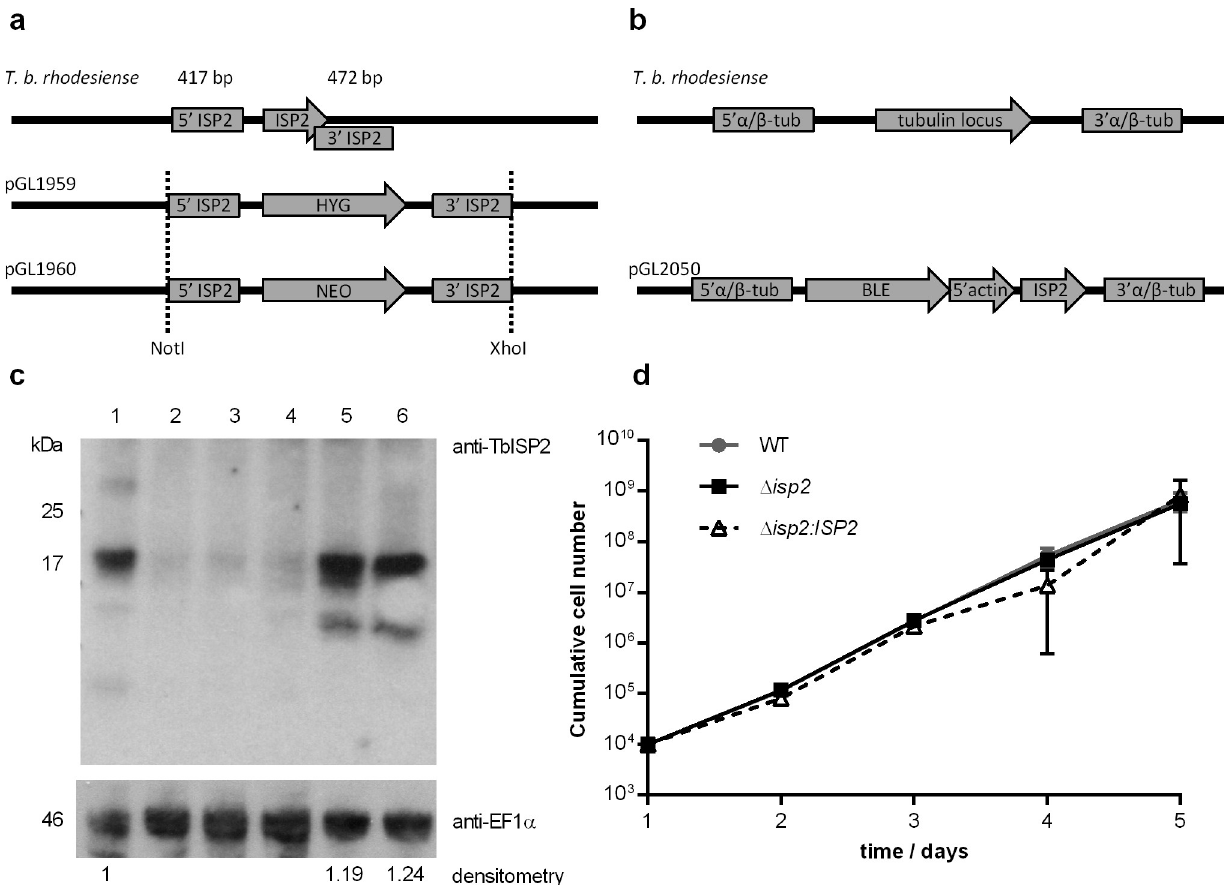
Fig 2. Generation of T . b . rhodesiense null mutants for TbISP2. (a) Schematic representation of the ISP2 locus of T . brucei before and after integration of hygromycin (HYG) and neomycin (NEO) resistance cassettes by homologous recombination using sequences containing the 5‘and 3‘flanking regions of Tb ISP2 , generating T . b . rhodesiense Δ isp2 . (b) Schematic representation of ISP2 reintegration into the tubulin locus of T . b . rhodesiense Δ isp2 parasites by homologous recombination using a cassette containing the coding sequence of Tb ISP2 flanked by fragments of the intergenic region of the T . brucei tubulin locus and a phleomycin (BLE) resistance gene, generating Δ isp2 : ISP2 . (c) Whole cell lysates were obtained from 5 × 10 6 parasites and analyzed by Western blotting with the anti-ISP2 antibody to assess protein expression in the different cell lines. An anti-EF1 α antibody was used as a loading control. Lane 1 –WT T . b . rhodesiense IL1852; Lanes 2, 3 and 4 – T . b . rhodesiense Δ isp2 clones 1, 2 and 3; Lanes 5 and 6 – T . b . rhodesiense Δ isp2 : ISP2 clones 1 and 2. Levels of ISP2 were calculated by densitometry in relation to WT and normalized to EF1 α . In lanes 5 and 6, the lower molecular mass bands were not considered in the densitometry. (d) Growth curves of BSF T . b . rhodesiense WT, Δ isp2 and Δ isp2 : ISP2 determined by cell counts on a hemocytometer after cells were seeded at 1 × 10 4 cells ml -1 . Cultures were diluted to 1 × 10 4 cells/ml every 48 h and the cumulative cell number was determined using the dilution factor. Data are represented as the mean ± SD. Experiment was performed in triplicate and graph is representative of 3 independent experiments. Statistical analysis was performed using Two Way ANOVA with Bonferroni posttest. containing the 5‘and 3‘UTR sequences of Tb ISP2 flanking drug resistance genes were con- structed and transfected into T . b . rhodesiense (Fig 2A), followed by analysis of drug-resistant clones to identify null mutants. Southern blot analysis of the mutants confirmed the integra- tion of drug-resistance cassettes in the Tb ISP2 locus (S1 Fig). Two Δ isp2 clones were subse- quently transfected with a recombination cassette containing the coding sequence of Tb ISP2 flanked by fragments of the intergenic region of the tubulin locus of T . b . brucei and a drug resistance gene (Fig 2B) for the generation of TbISP2 re-expressing lines ( Δ isp2 : ISP2 ). Western blotting of parasite lysates confirmed the absence of the ISP2 protein in the null mutant lines (Fig 2C, lanes 2–4) and the expression of TbISP2 in the re-expressing lines (Fig 2C, lanes 5–6). Densitometry, followed by normalization against loading controls, revealed that Δ isp2 : ISP2